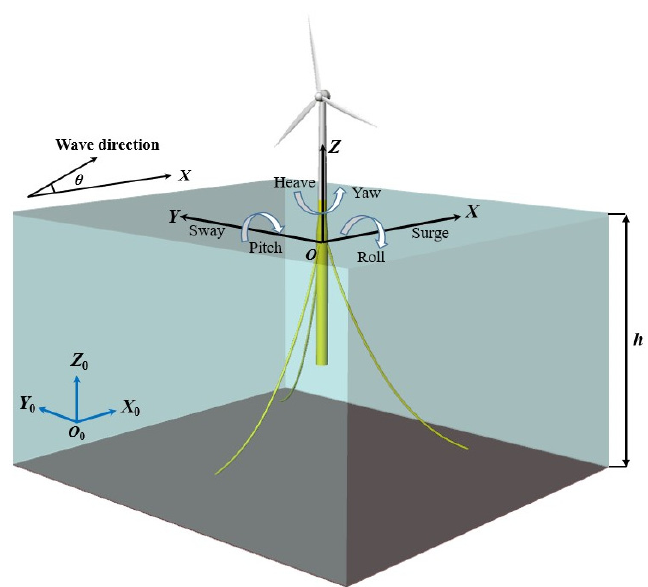
Figure 7. The schematic diagram of earth (O 0 -X 0 Y 0 Z 0 ) and body-fixed (O-XYZ) coordinate systems.